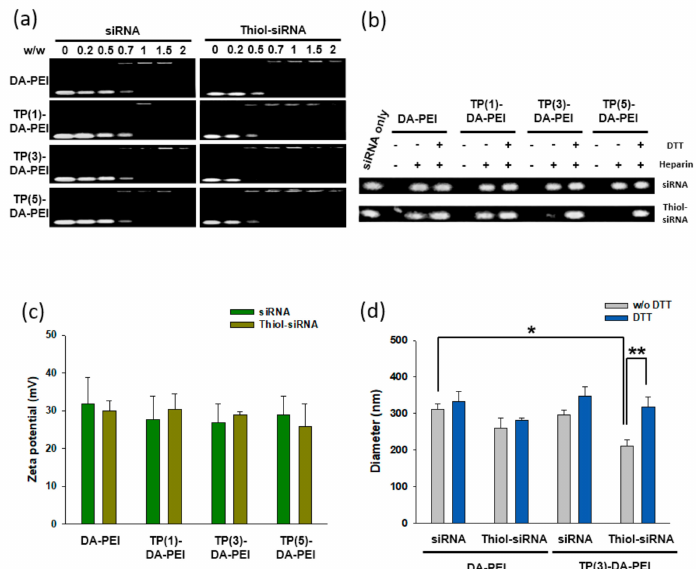
Figure 2. Gel retardation assay of ( a ) small interfering RNA (siRNA) condensed with DA-PEI, TP(1)-DA-PEI, TP(3)-DA-PEI, and TP(5)-DA-PEI at polymer/siRNA weight ratios from 0 to 2 and ( b ) the examination of the formation of disulfide bonds in various polyplexes at polymer/siRNA weight ratio of 3 on 1% (W/V) agarose gel and stained with ethidium bromide. ( c ) The zeta potential values of TP-DA-PEI at polymer/siRNA weight ratio of 3. The results are presented as means ± SD. ( d ) Effect of the formation of disulfide bonds on the sizes of polyplexes (polymer/siRNA weight ratio = 3), measured by dynamic light scattering (DLS) analysis. The results are presented as means ± SD and analyzed using Student’s t -test ( n = 3, * p < 0.05, ** p <